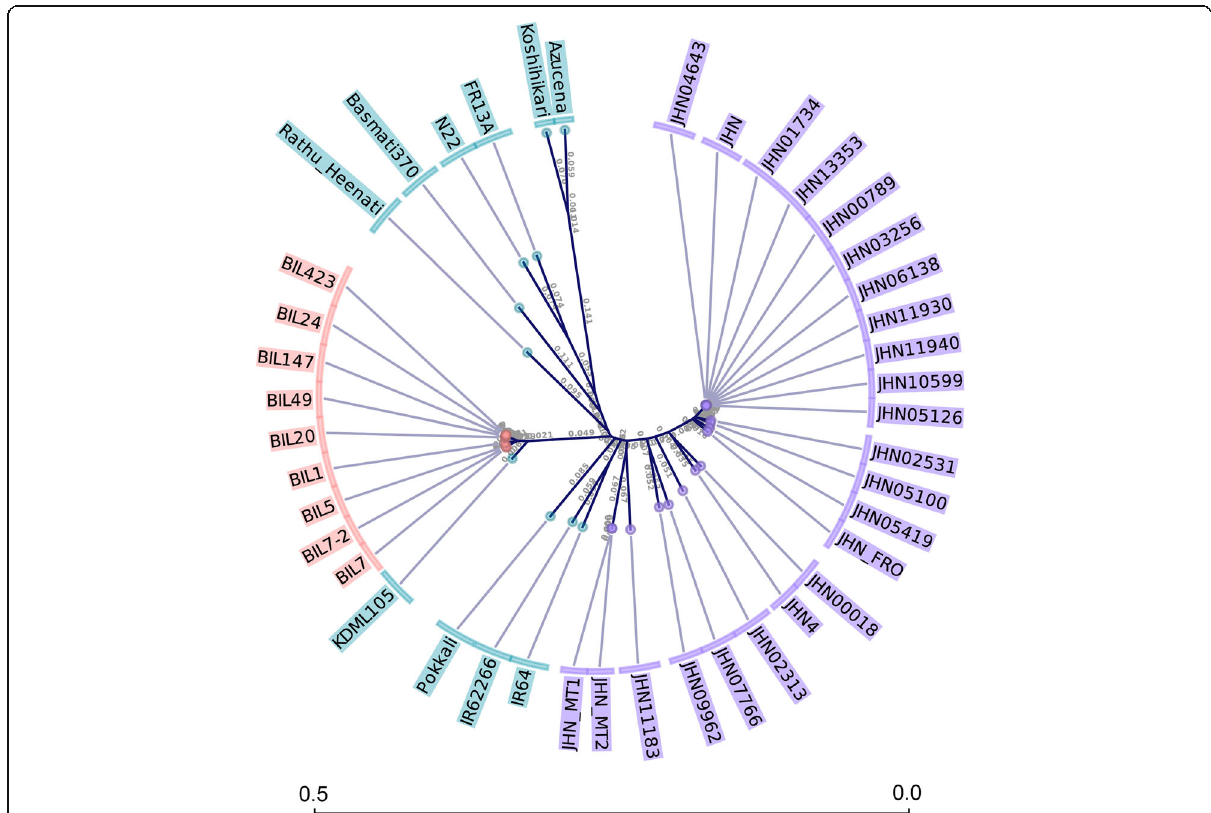
Fig. 4 Phylogenetic analysis of the mutant lines, JHN-WT, KDML105, RH, BILs, and other germplasm rice accessions. The evolutionary history was inferred using the UPGMA